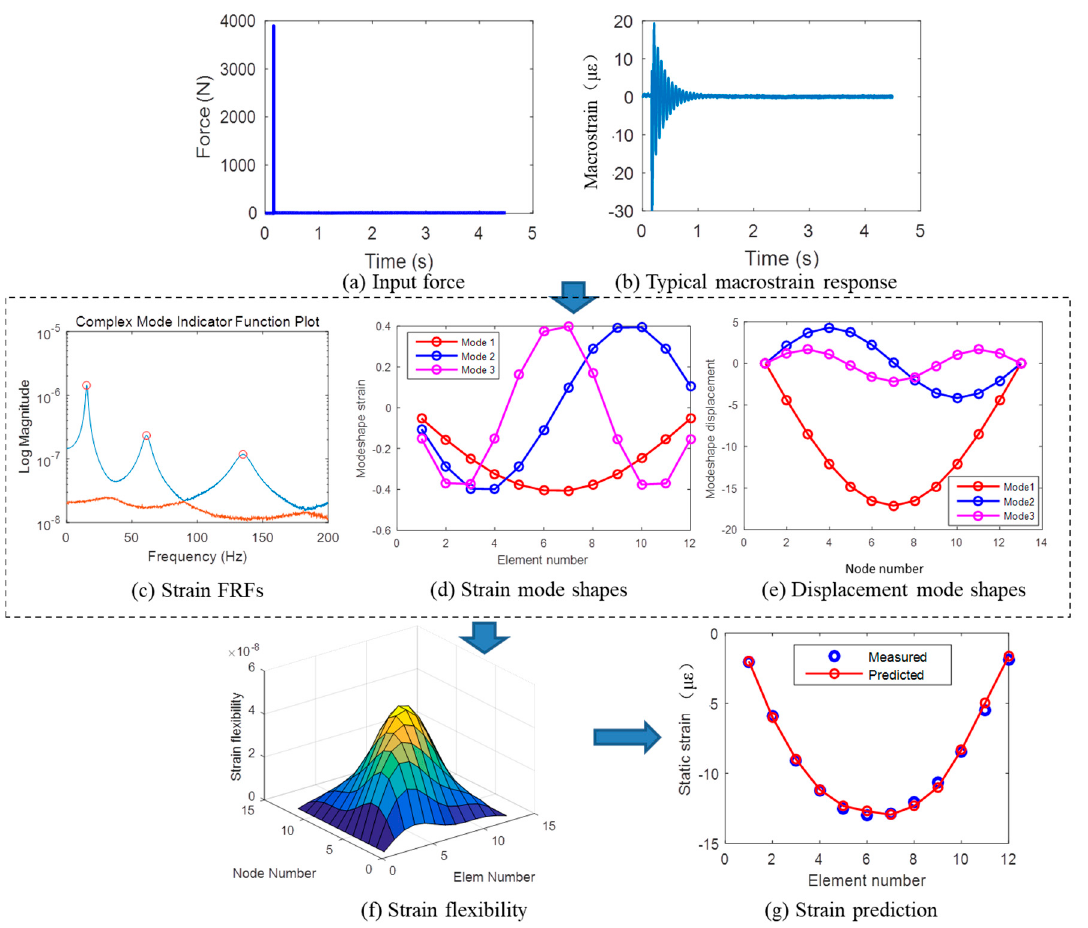
Figure 4. Process of strain flexibility identification for intact structure.